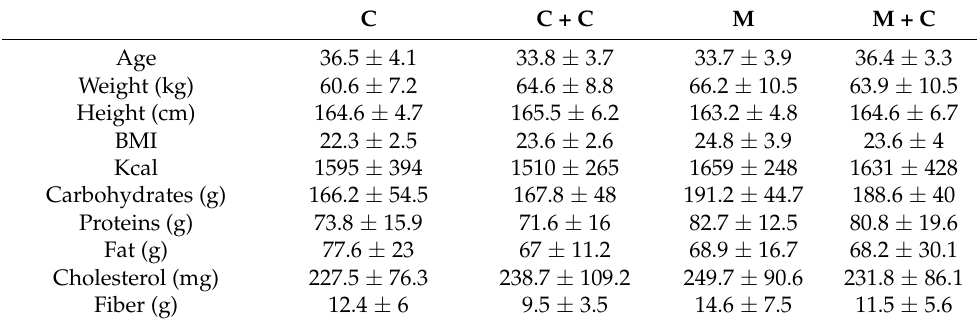
Table 1. Anthropometric measurements and dietetic assessment (daily average).